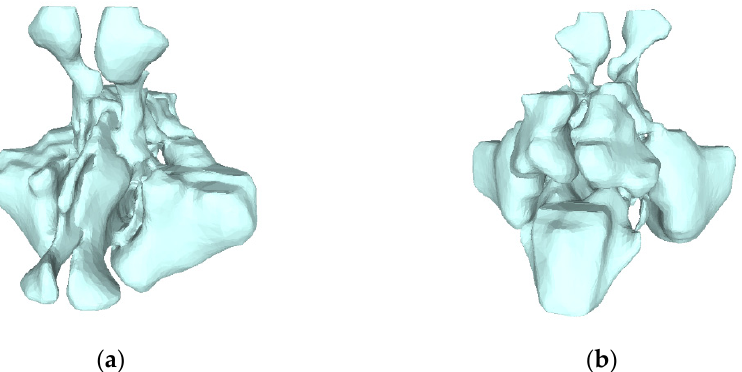
Figure 26. ( a , b ) are the marching Cube 3D reconstruction of overall paranasal sinuses (unit: mm).